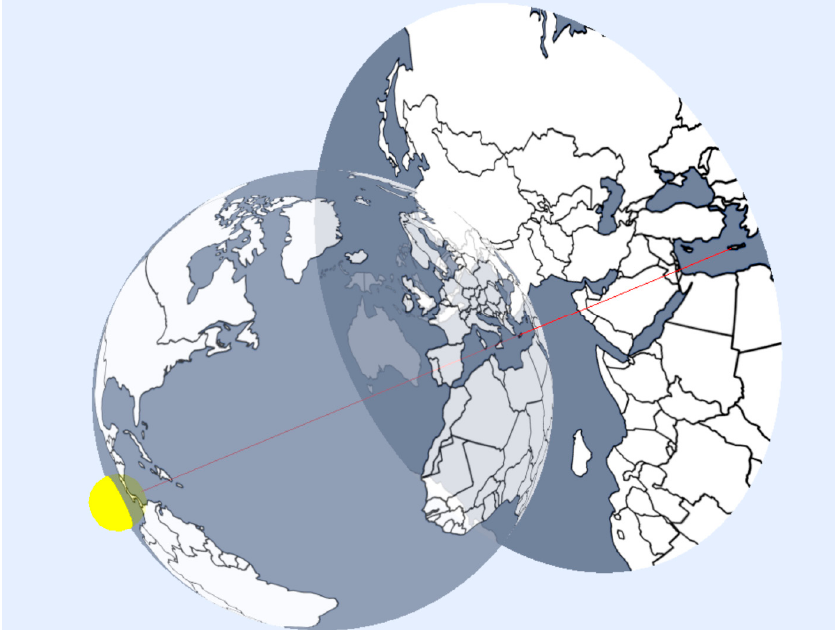
Figure 2. An interactive visualization following the light source metaphor to construct a map projection. The yellow sphere represents the point light source as the projection center. Illustrated is an example projection line, intersecting the globe in Cyprus and “drawing” the respective color on the projection surface (a disc).